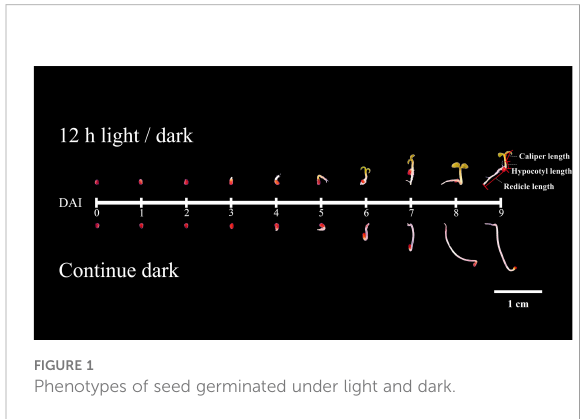
FIGURE 1 Phenotypes of seed germinated under light and dark.